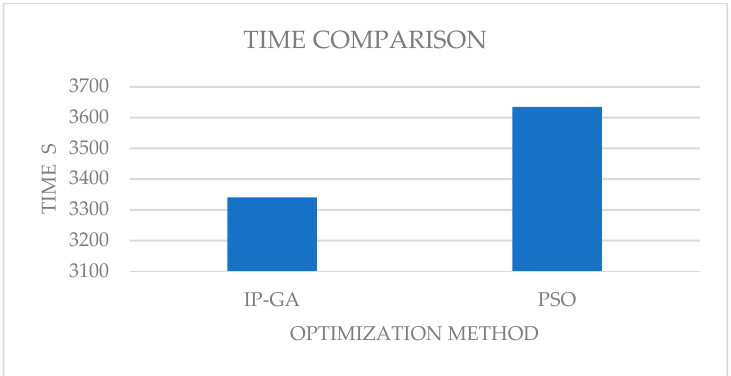
Figure 9. Value result of the function fitness for the proposed methods.